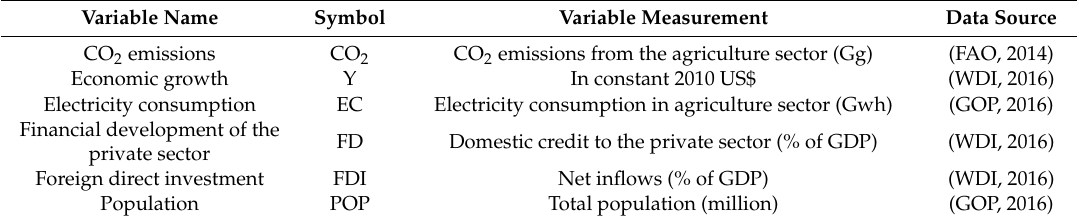
Table 1. Study variables name, symbols, measurement and data